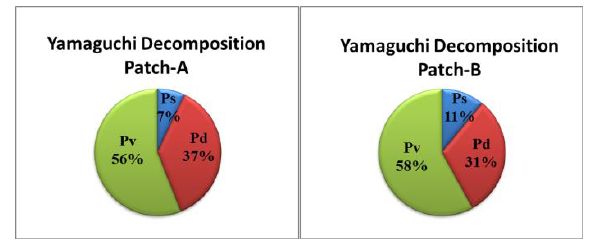
Figure 3 Percentages of different kind of scattering powers for selected patches in Figure 2.